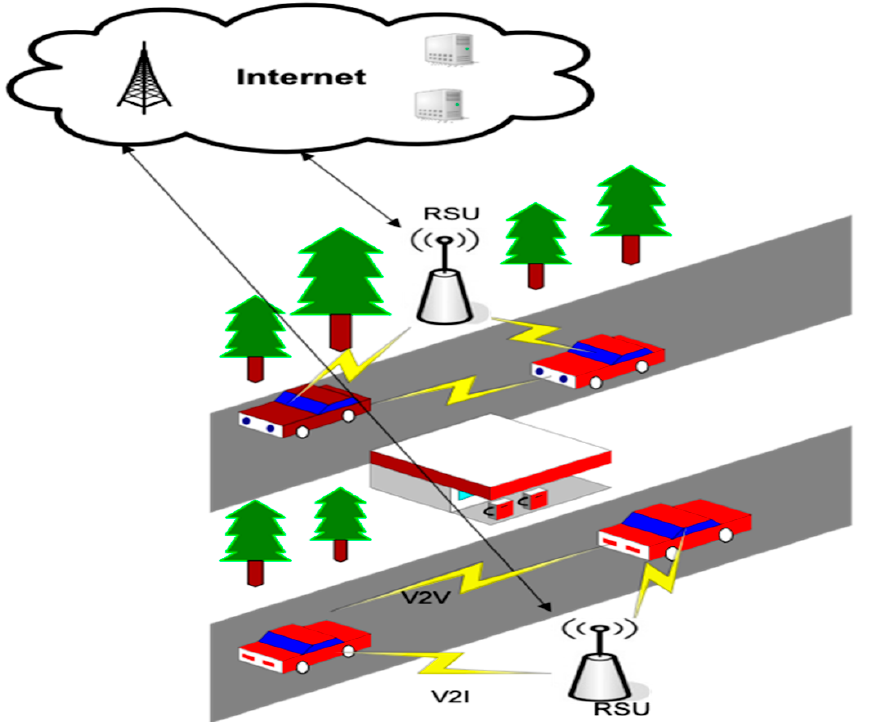
Figure 2. Communication architecture under the VANET environment [16].